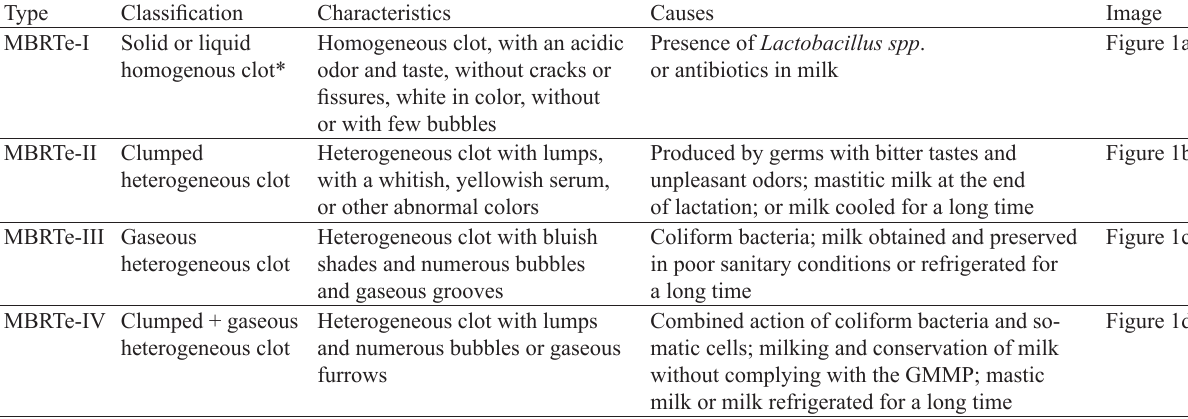
Table 1 Types, characteristics, and possible causes of clots obtained from the extended methylene blue reduction test